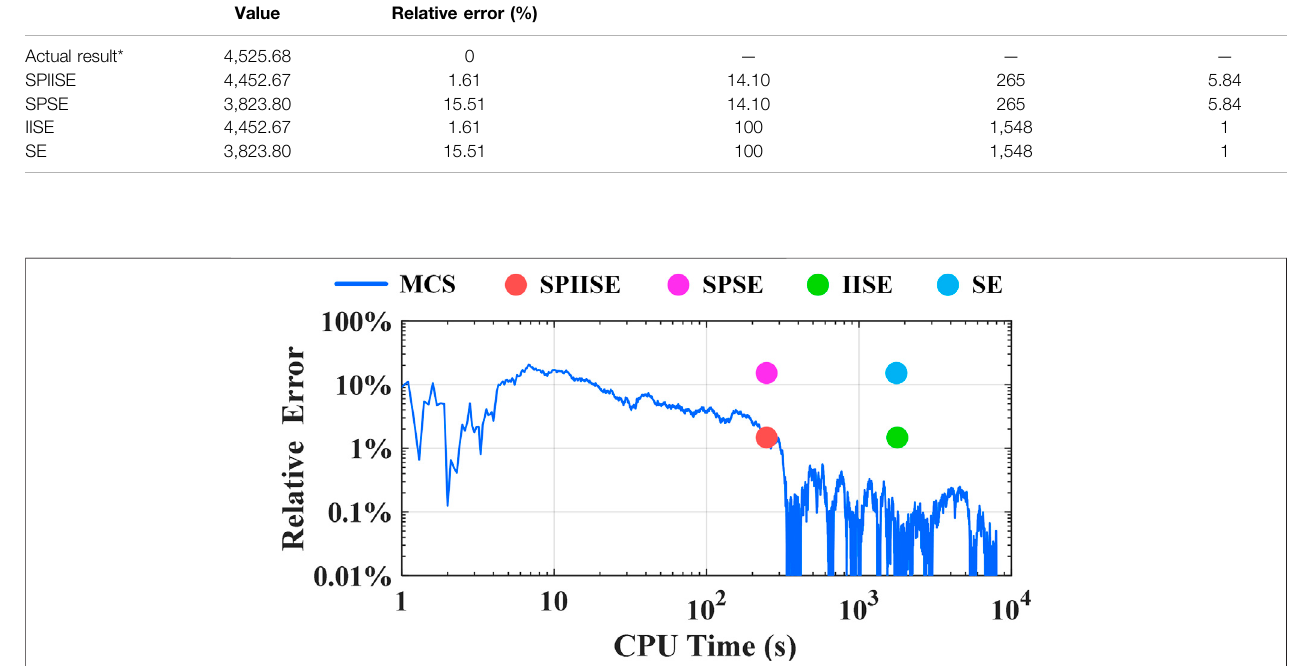
FIGURE 8 | Comparisons of computation ef fi ciencies of fi ve methods (RTS-79).